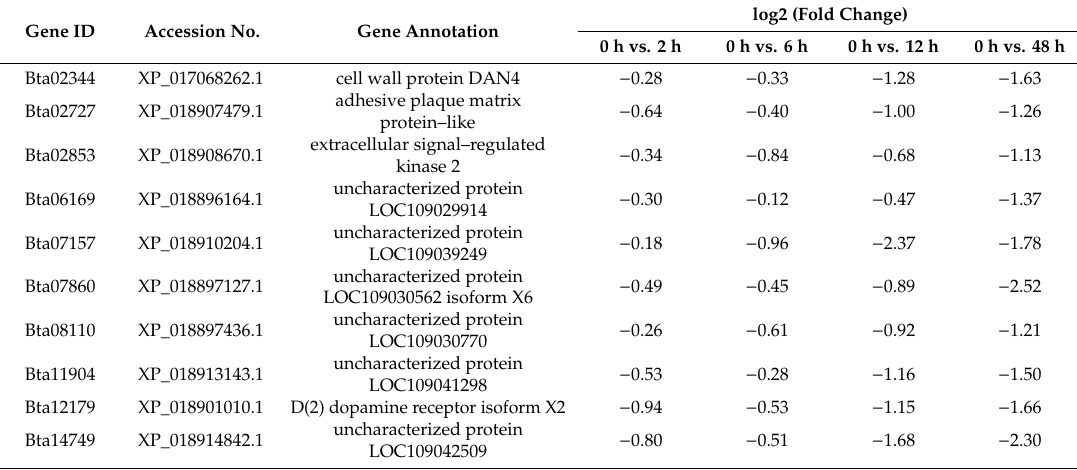
Table 3. The expression profiles of the temporally down-regulated genes in the IL 17 signalling pathway after di ff erent AAPs on TYLCV-infected plants.